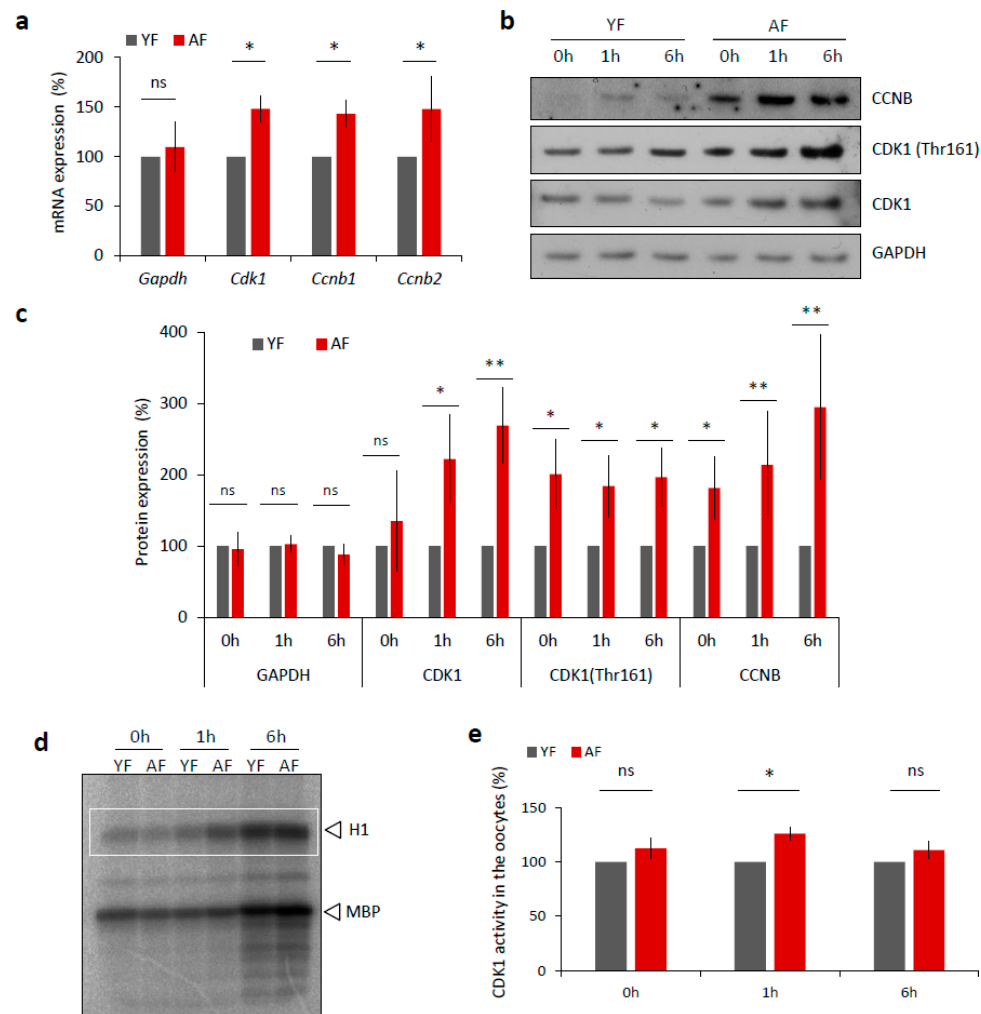
Figure 4. Expression of MPF components and its activity is increased in the oocytes from aged females. ( a ) RT-PCR quantification of mRNA coding for CDK1 and B-type cyclins, as well as loading control Gapdh in the GV oocytes (0 h) from different age groups. For quantification of total RNA content in oocytes from YF and AF groups see Figure S3a. Values obtained for the YF group were set as 100%. Data was derived from at least four experiments of biologically different samples. Columns represent mean; error bars ± SD; ns non-significant; * p < 0.05, Student’s t- test. ( b ) Western blot analysis of CDK1, CDK1 (Thr161) and CCNB during oocyte maturation (0 h, 1 h and 6 h) in the both age groups. See Figure S3b,c for the assessment of global translation in oocytes from YF and AF groups. ( c ) Quantification of MPF components, CDK1, its phosphorylation (Thr161), CCNB and GAPDH as a loading control. Values obtained for the YF group were set as 100%. From at least three experiments of biologically different samples. Columns represent mean ± SD; * p < 0.05; ** p < 0.01; bars with ns are non-significant; Student’s t- test. ( d ) Representative image of analysis of CDK1 activity (H1) in the oocytes after isolation (0 h), NEBD (1 h) and at metaphase I (6 h). Kinase assay was done with oocytes of both female age groups. CDK1 activity was measured towards histone H1 as external substrate, marked by white rectangle. ( e ) Quantification of CDK1 (H1 substrate) activity during oocyte maturation from YF and AF groups. Measurements originated from four experiments of biologically different samples. Values obtained for the YF group were set as 100%. Columns represent mean; error bars ± SD; ns non-significant; * p < 0.05; Student’s t